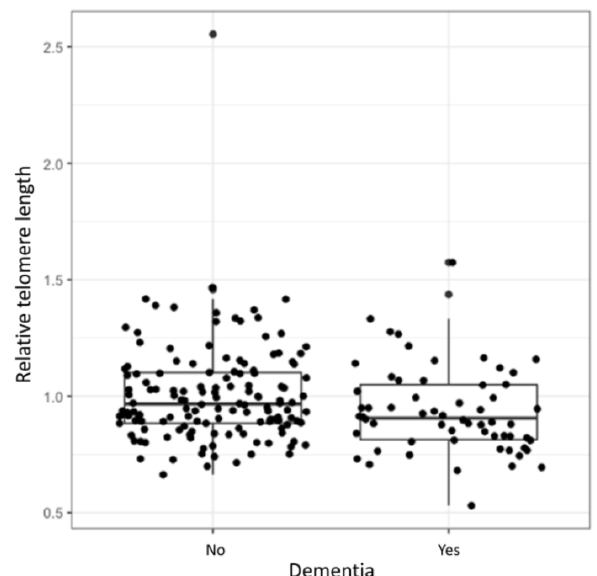
Figure 1. Relative TL in relation to dementia. Median relative TL of a cohort with and without dementia (range between the 1st and 3rd